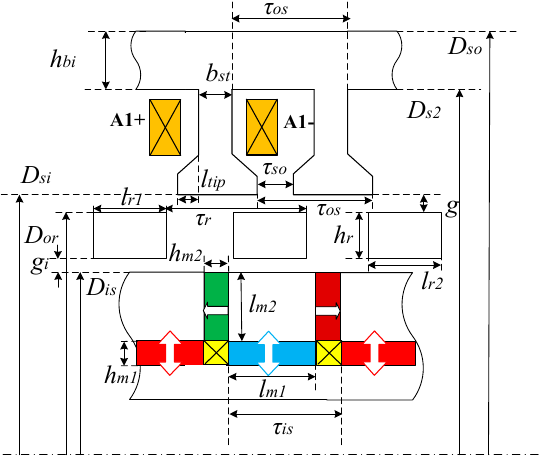
Figure 6. Illustration of design parameters of PS-SF-HMMM. Table 2. Design Specifications of the 6-Stator-Slot